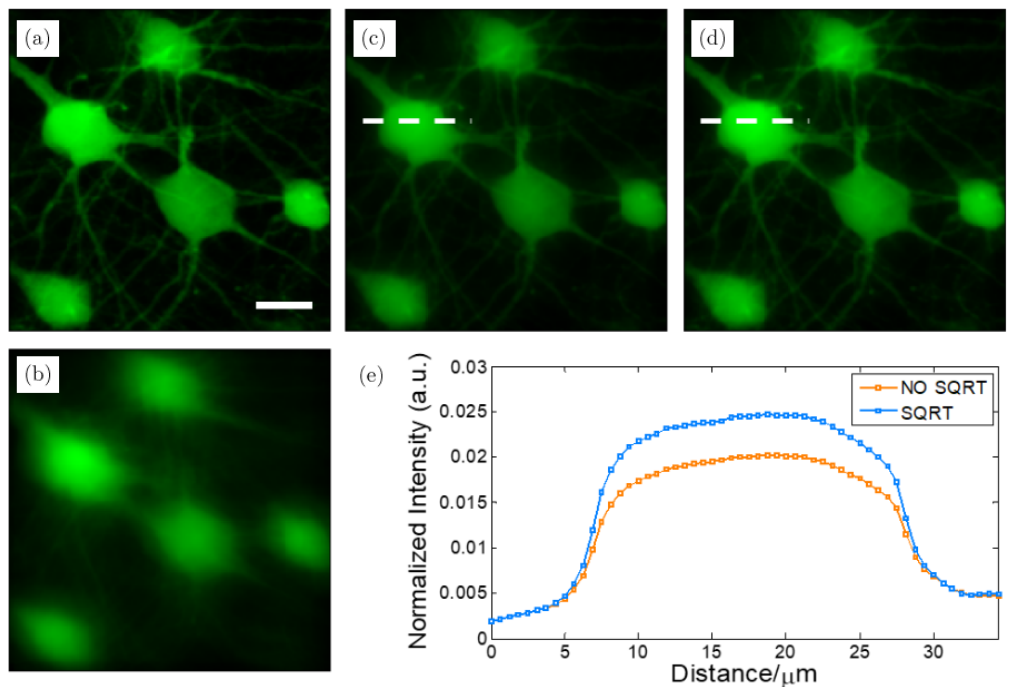
Fig. 6. (a) The ideal imaging of a slice of mouse brain tissue without the scattering medium (scale bar: 20 (cid:1) m). (b) The image distorted by the medium. (c) The corrected image using the conventional method. (d) The corrected image using our method. (e) The intensity pro¯les along the white dashed lines shown in (c) and